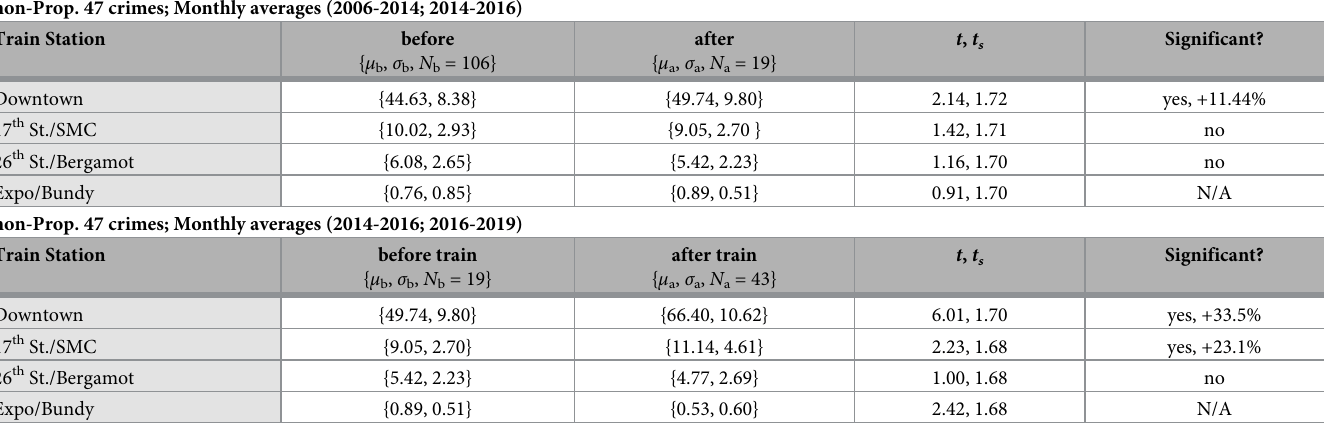
We also considered the impact of Prop. 47 on the eight neighborhoods that comprise the city and verified that the largest monthly change in crime, at +37.2%, occurred Downtown, an area with many opportunistic crime attractors including nightlife, tourists, dining venues, and shopping centers. Finally, we examined the effects of the opening of the Expo Line on monthly crime rates within 450 meters of the locations of four new transit stations. We found that reported crime increased significantly at the Downtown Santa Monica station, the 17 th Street/ Santa Monica College station, and the Expo/Bundy station. Prop. 47 and non-Prop. 47 percent increases were comparable at the Downtown Santa Monica stop, at +30.6% and +33.5% respectively. In contrast, at the 17 th Street/Santa Monica College stop, the increase for reported Prop. 47 crimes was +38.6%, much higher than for non-Prop. 47 ones, at +23.1%. Table 6. Statistical tests on reported non-Prop. 47 crime in the vicinity of light rail station locations in Santa Monica, CA, during three successive time periods span- ning 2006–2019. non-Prop. 47 crimes; Monthly averages (2006-2014;